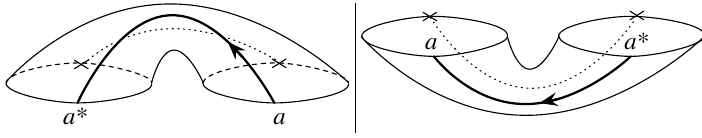
Figure 41 . The basic building blocks of a 2d TFT with C symmetry.